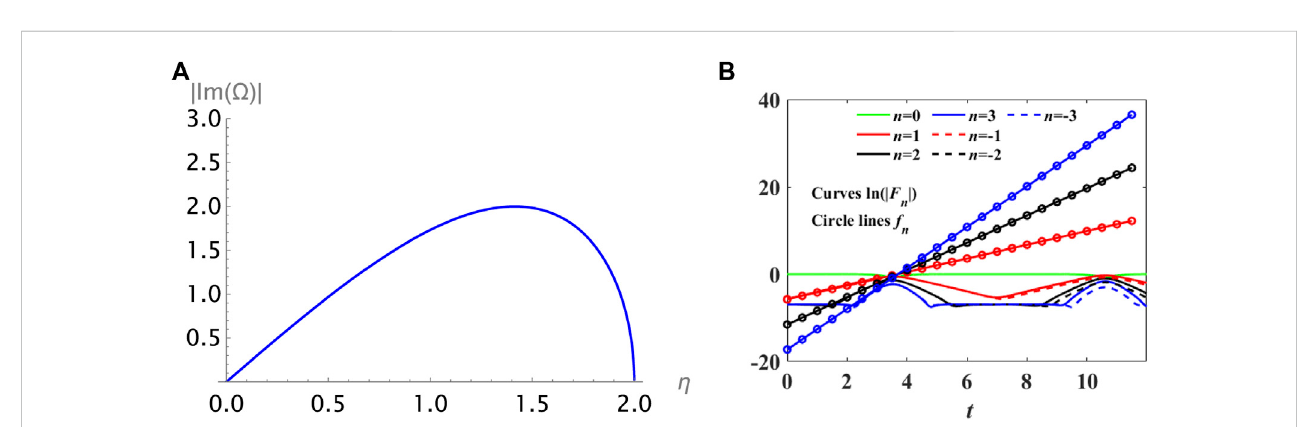
FIGURE 5 (A) Growth rate of modulation instability with parameters α = 1, β = 1 × 10 − 6 , κ = − 1, ρ = 1, γ 1 = 0; (B) Comparison between the numerical spectra and the cascading mechanism